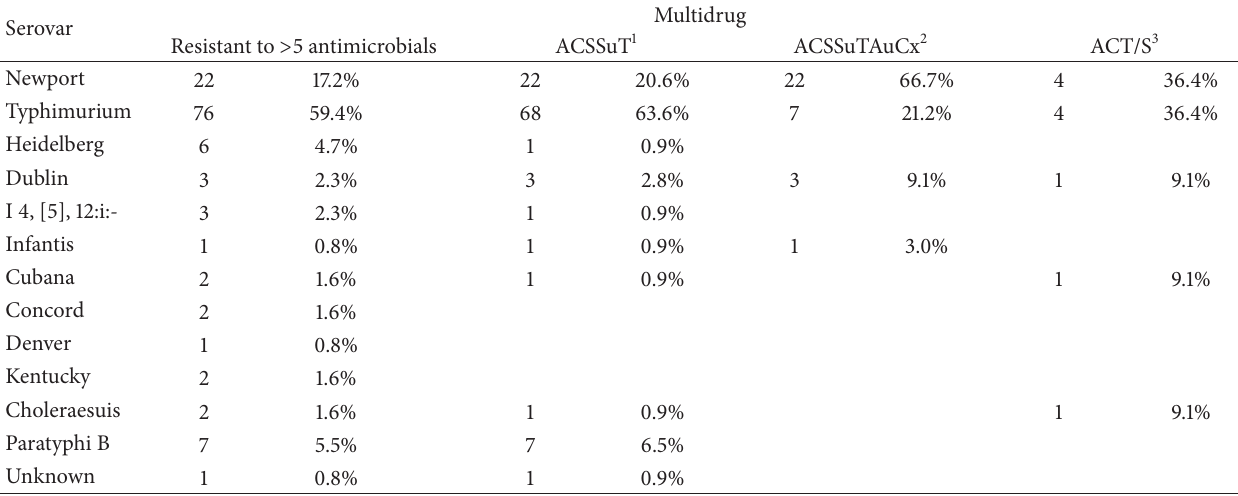
Table 9: Examples of nontyphoidal Salmonella isolates from US patients and their multidrug resistance profile [75].